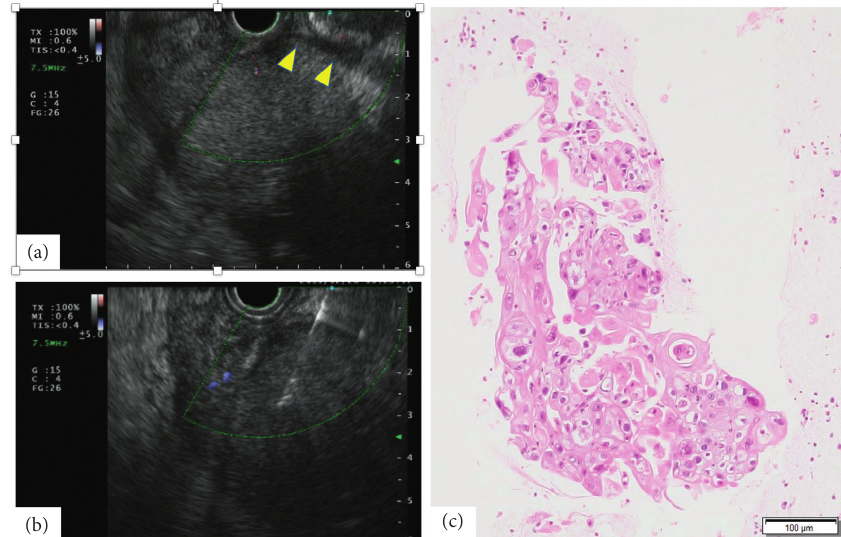
Figure 4: (a) Endoscopic ultrasound view from the gastric station showing no significant amount of ascites. Arrowheads correspond to the surface of an exposed hepatic mass. (b) Endoscopic ultrasound-guided fine-needle aspiration of the liver mass performed from the view without worrisome vasculature or ascites. (c) Histopathological view of squamous cell carcinoma with hematoxylin and eosin staining. Components of neither hepatocellular carcinoma nor adenocarcinoma are